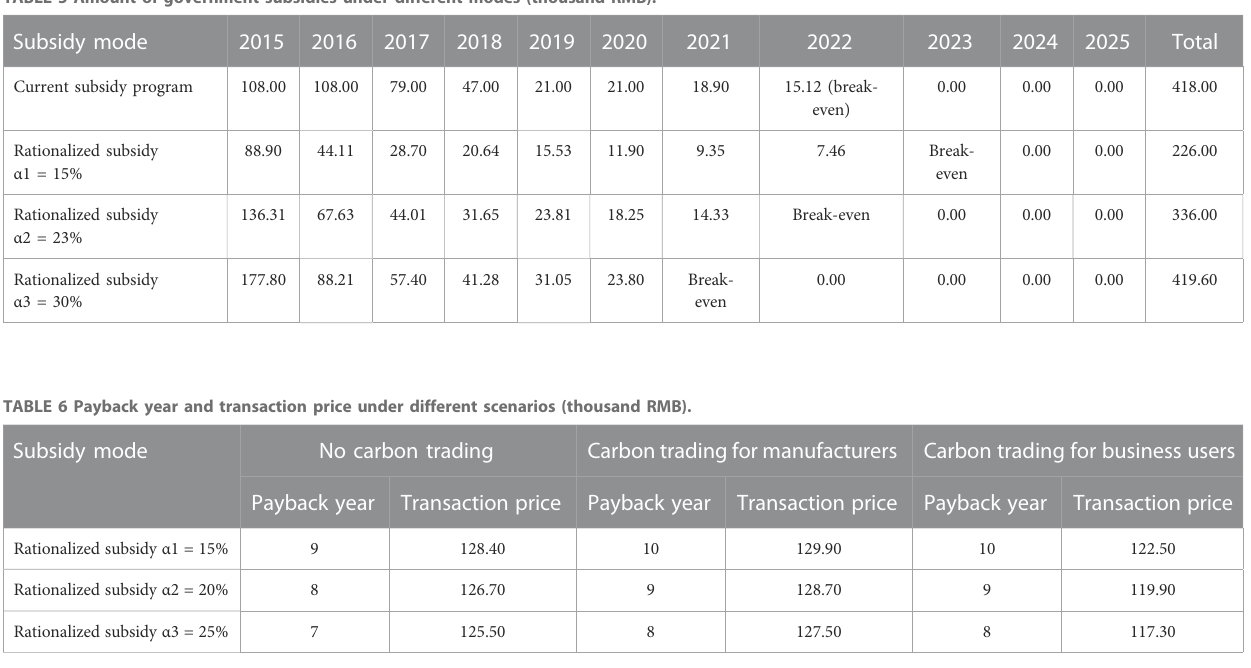
TABLE 5 Amount of government subsidies under different modes (thousand RMB).